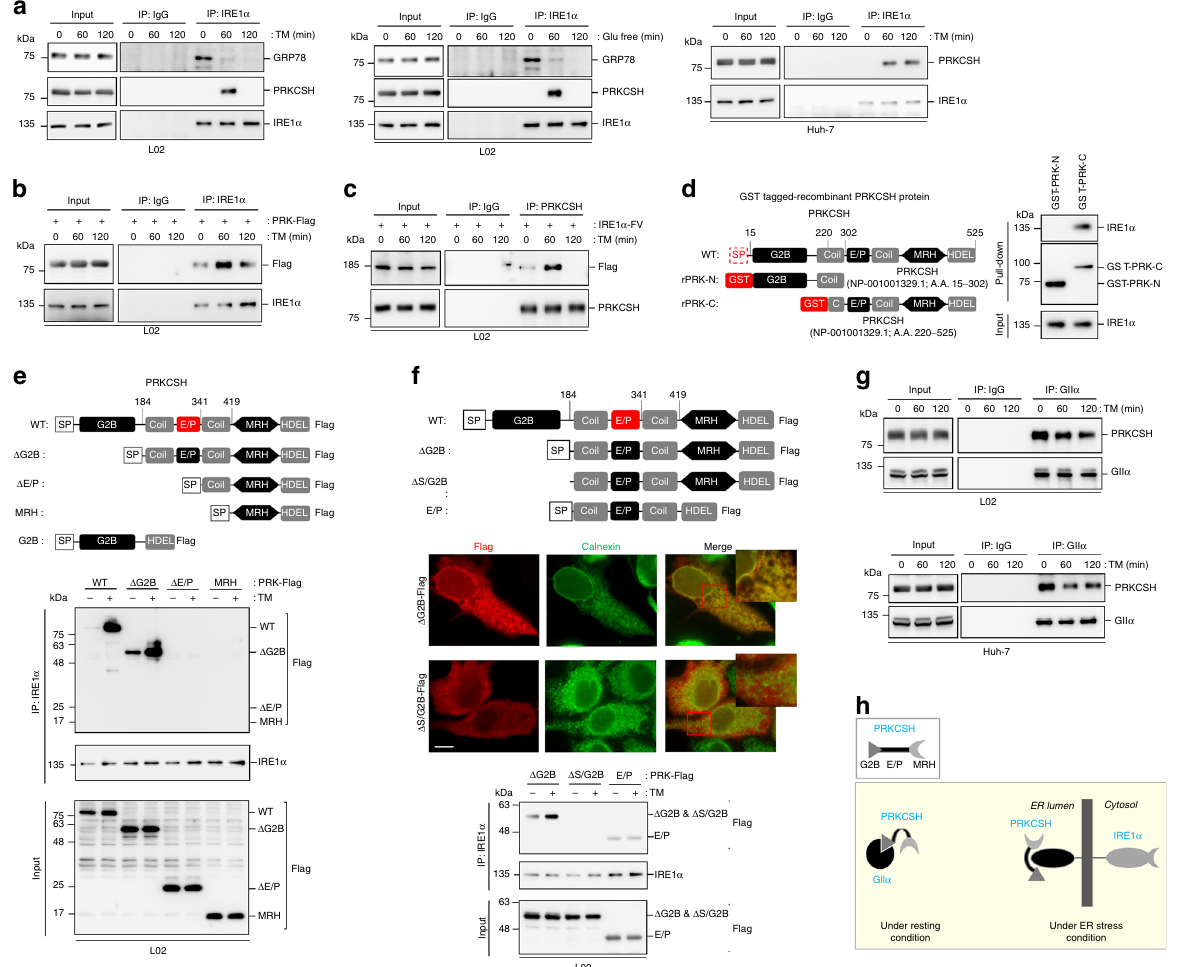
Fig. 5 Internal E/P domain of PRKCSH is required for its interaction with IRE1 α and boosting IRE1 α activation under ER stress. a Immunoblot analysis of association between endogenous PRKCSH and IRE1 α using immunoprecipitates from L02 cells treated with 10 μ g/mL TM (left) or glucose-free medium (middle) for the indicated time, and from Huh-7 cells treated with 10 μ g/mL TM (right) for the indicated time. b Immunoblot analysis of complex formation between endogenous IRE1 α and Flag-tagged PRKCSH immunoprecipitated from transfected L02 cells treated with 10 μ g/mL TM for the indicated time. Immunoprecipitation was performed by using anti-IRE1 α antibody and normal rabbit IgG as a control antibody. c Immunoblot analysis of complex formation between endogenous PRKCSH and Flag-tagged IRE1 α . Immunoprecipitates were prepared from transfected L02 cells treated with 10 μ g/mL TM for the indicated time. Immunoprecipitation was performed by using anti-PRKCSH antibody and normal rabbit IgG. d Schematic diagram of the functional domains of PRKCSH and its recombinant variants (left part). Immunoblot analysis of in vitro complex formation between IRE1 α and GST-tagged PRKCSH protein (right part). e , f Schematic presentation of wild-type and deletion mutants of PRKCSH (upper part). Immunoblot analysis of complex formation between endogenous IRE1 α and Flag-tagged mutant PRKCSHs (lower part). Immunoprecipitates were prepared from transfected L02 cells treated with 10 μ g/mL TM for 1 h. Immunocytochemical analysis of L02 cells transfected with Flag-tagged Δ G2B and Δ S/G2B mutant PRKCSH ( f , middle). Calnexin was used as an ER marker. Scale bars represent 5 µ m. g Immunoblot analysis of association between endogenous PRKCSH and GII α . Immunoprecipitates were prepared from L02 (top) or Huh-7 cells (bottom) treated with 10 μ g/mL TM for the indicated time. Immunoprecipitation was performed by using anti-GII α antibody and normal rabbit IgG. h Model of PRKCSH complex formation. Under resting conditions, PRKCSH associates with the GII α subunit via the G2B domain; this domain inhibits PRKCSH interaction with IRE1 α . Under ER stress, PRKCSH dissociates from GII α and then binds to IRE1 α via the E/P